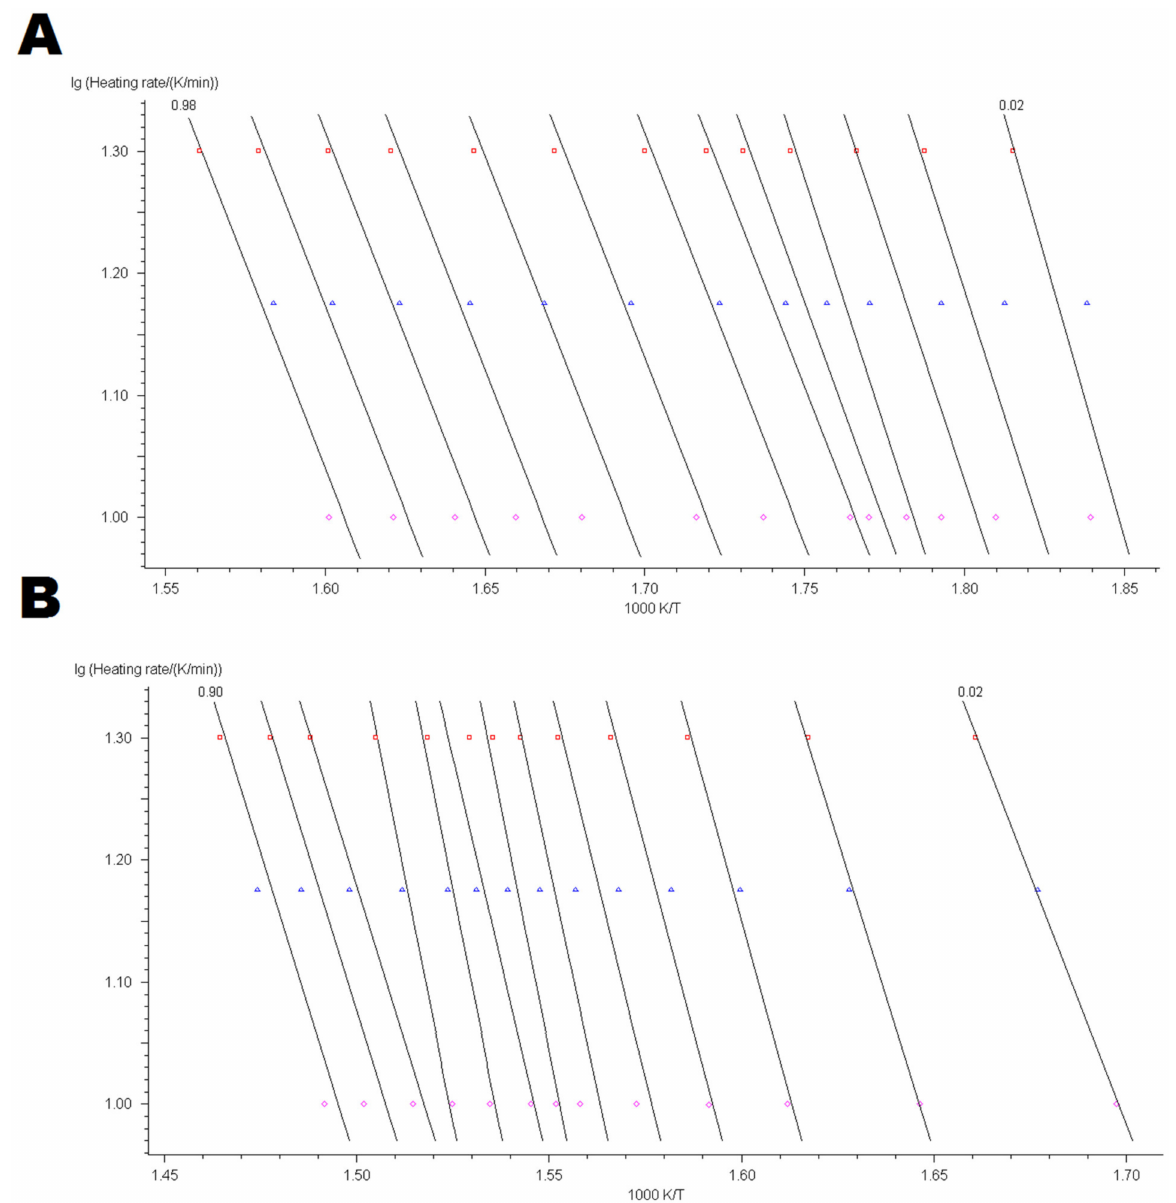
Figure A4. Ozawa-Flynn-Wall POM-R analysis plot lg (heating rate) vs. 1000 K/T: ( A ) sample investigated in an oxygen atmosphere; ( B ) sample investigated in an inert atmosphere. Lines are drawn through isoconversion points for the measurement with 10 ( ♦ ), 15 ( ∆ ), and 20 ( (cid:3) ) ◦ C/min heating